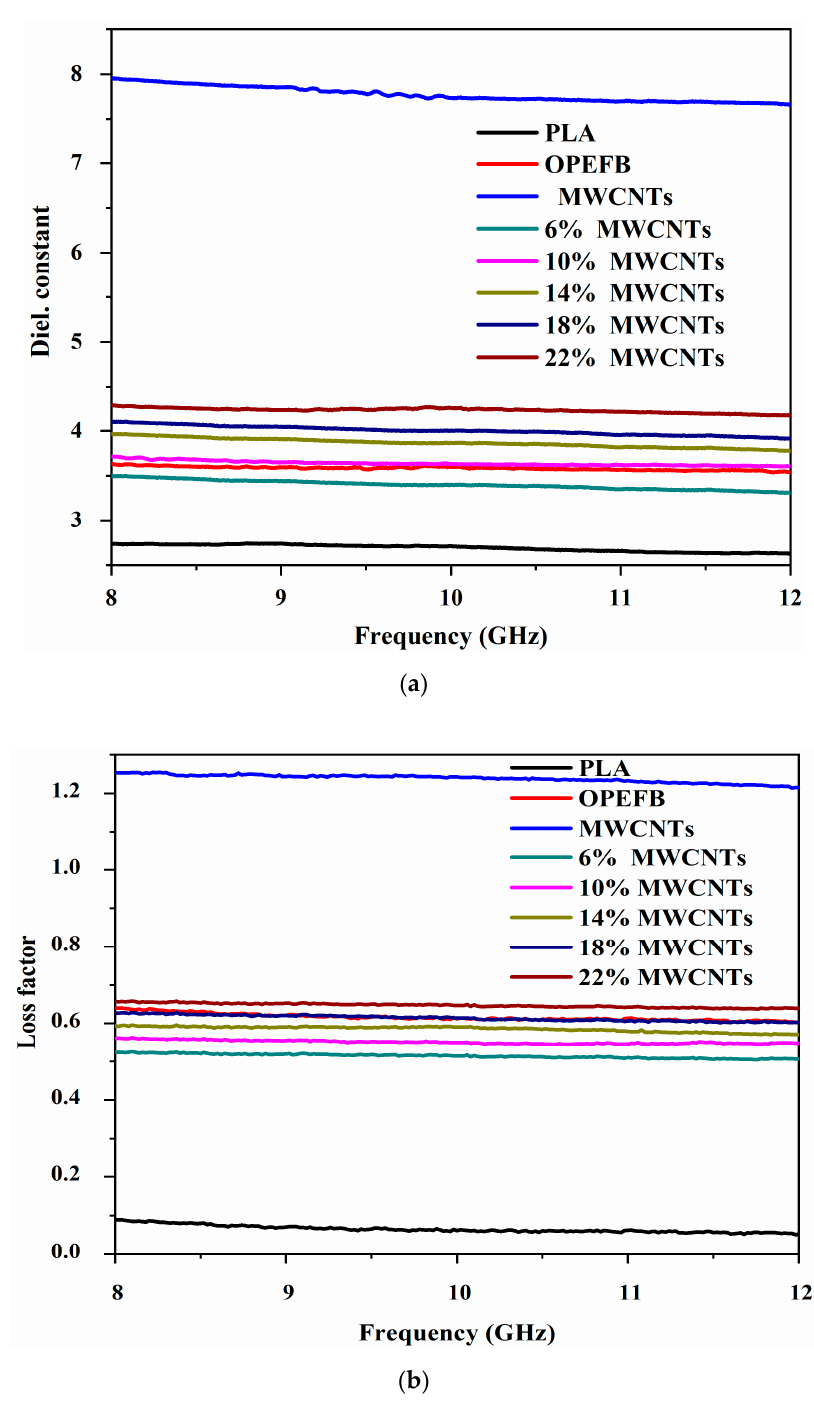
Figure 7. Variation in: ( a ) dielectric constant ( ԑ ’); ( b ) loss factor ( ԑ ”) of OPEFB/PLA/MWCNTs.